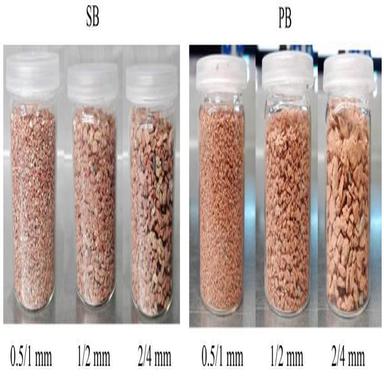
Grain groups 0.5–1 mm, 1–2 mm and 2–4 mm of the used SB- and PB-RBA.